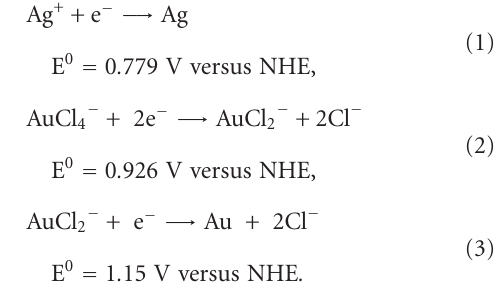
ions are reduced in mild conditions as compared with silver ions, according with the reduction potentials